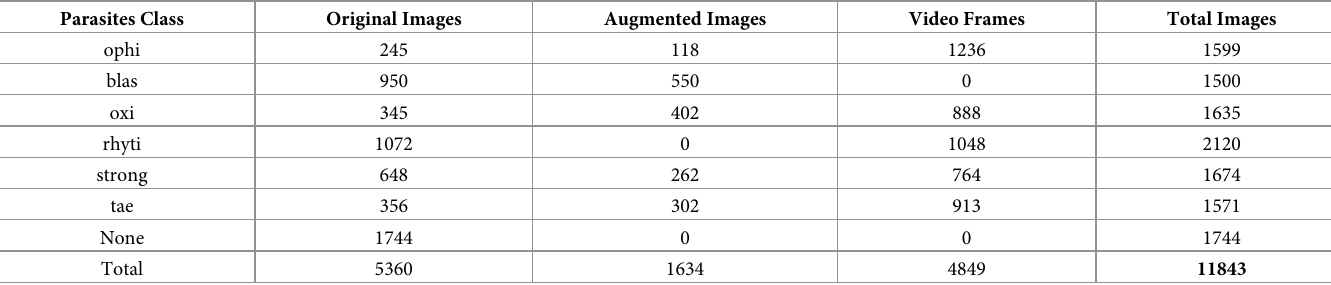
Table 2. Total number of images in the parasites database after data augmentation. Parasites